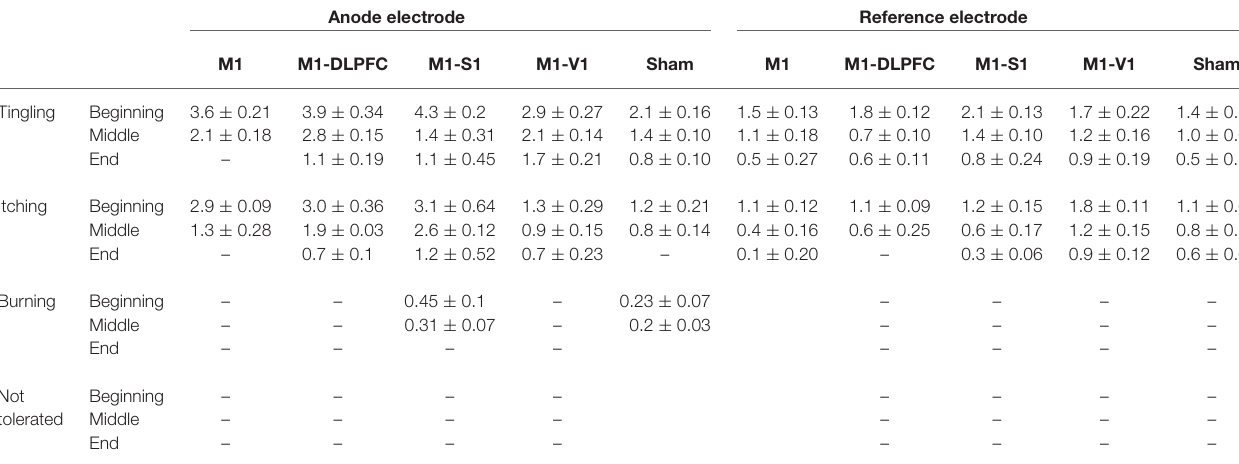
TABLE 2 | Participant’s sensation scores during experimental conditions. Anode electrode Reference